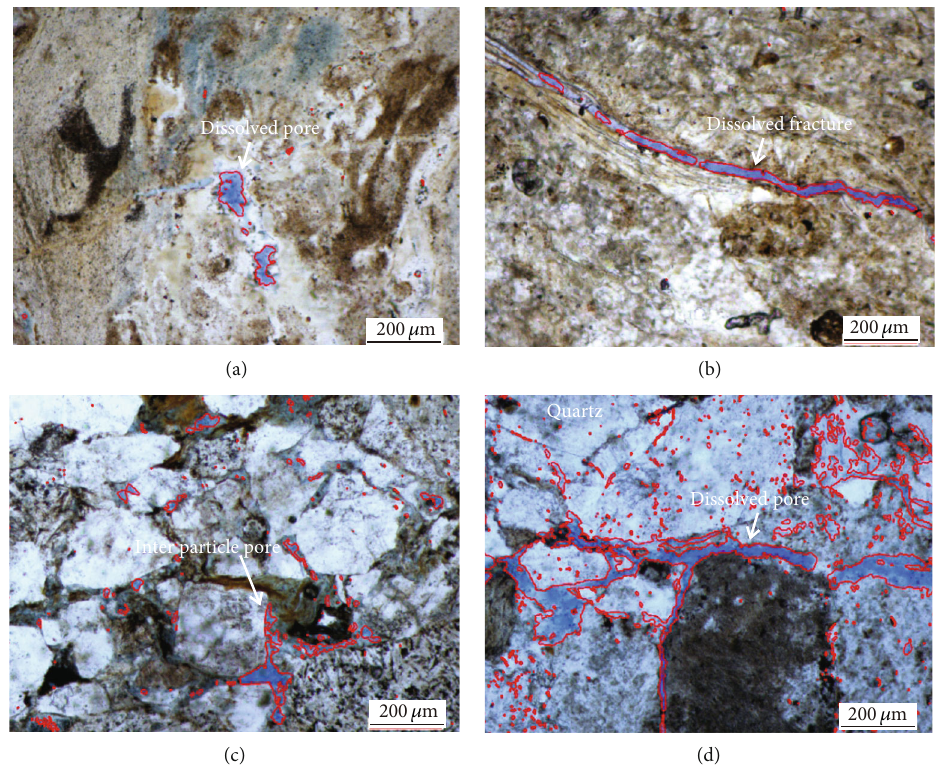
Figure 11: Thin section observed by plane-polarized and light perpendicular-polarized light for tight sandstone reservoir samples for the K yc. (a) 2522m, tu ff aceous sandstone; (b) 2543m, tu ff aceous sandstone; (c) 2803.5m, tu ff aceous sandstone; (d) 2912.5m, tu ff aceous 1 sandstone ((c) and (d) are referenced from